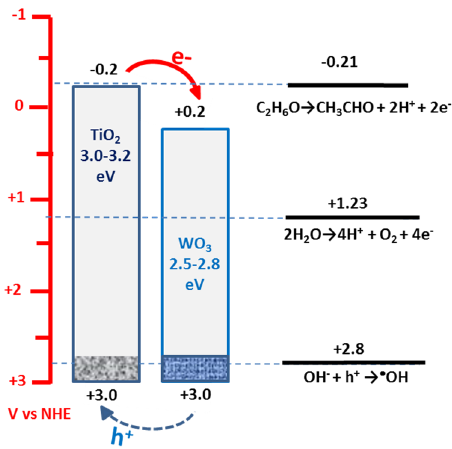
Figure 6. Approximate band levels for nanoparticulate TiO 2 and WO 3 and oxidation potentials of the possible hole scavengers in the present system.